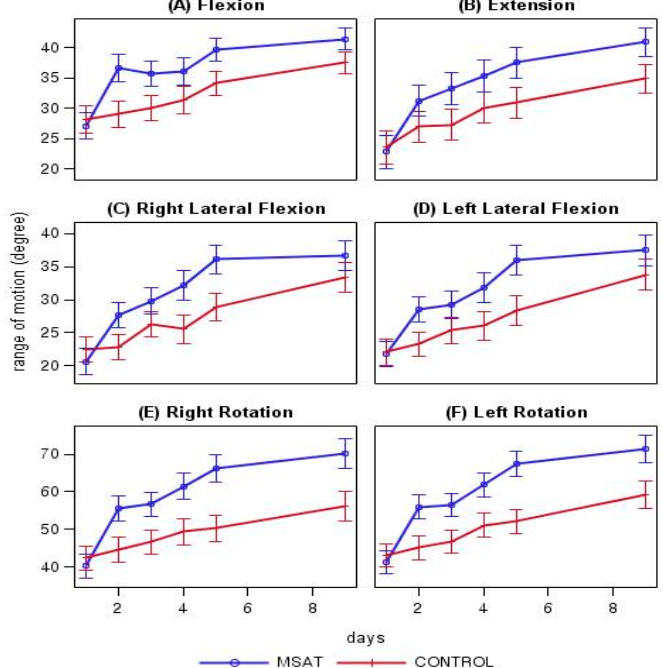
Figure 2. Comparison of range of motion between the MSAT and control groups. All figures show curves for the treatment period (baseline to discharge), with 95% confidence intervals represented by vertical bars. The plots and 95% confidence intervals were determined using a linear mixed model. From day 2 (after one session of treatment), the range of motion during all types of movements was greater in the motion style acupuncture treatment (MSAT) group than in the control group.